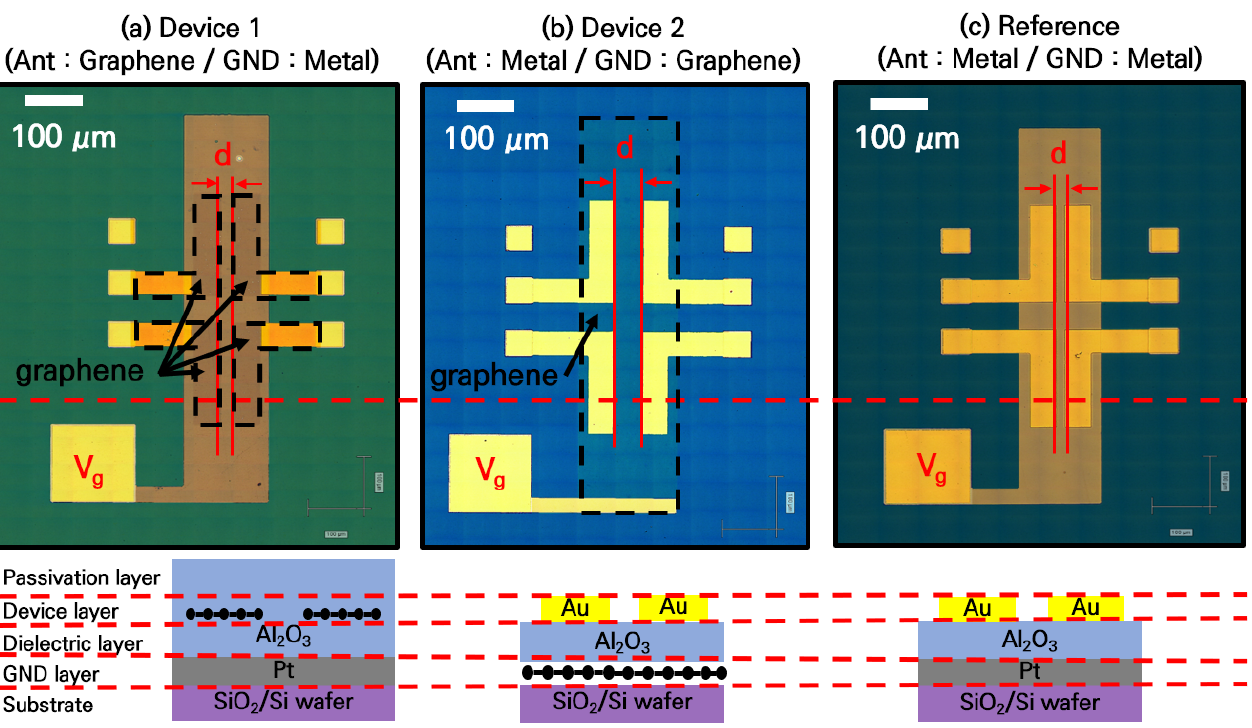
Figure 1. Optical images of the RF passive devices. Two dipole antennas are integrated on the same plane, and the ground plane is used as a gate to control the graphene Fermi level. ( a ) Device 1: has an antenna consisting of graphene patterns and ground metal. ( b ) Device 2: Graphene is used as the ground plane and the antenna is made of a metal film to increase the signal transmission rate of the device and induce a quantum capacitance change in graphene. ( c ) Reference device fabricated with Au paerns.